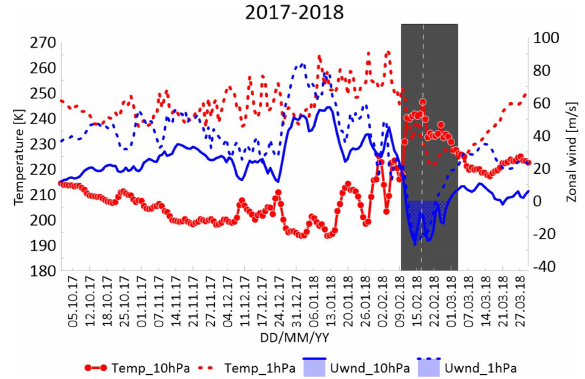
Figure 5. Same as Fig. 2 but October 2017 through March 2018.